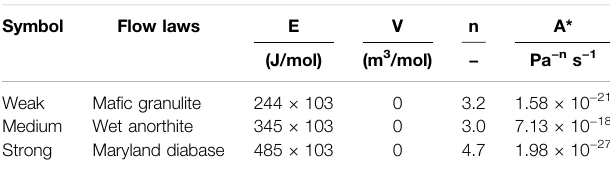
TABLE 2 | Viscous fl ows used for retrocontinental lower